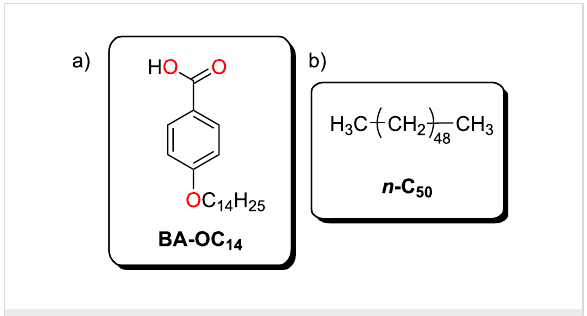
Figure 1: Molecular structures of (a) 4-tetradecyloxybenzoic acid ( BA-OC 14 ) and (b) n -pentacontane ( n -C 50 ) used in this study. Mono- layers of n -C 50 were used as buffer layers to physically decouple the monolayers formed by BA-OC 14 from the underlying graphite sub-